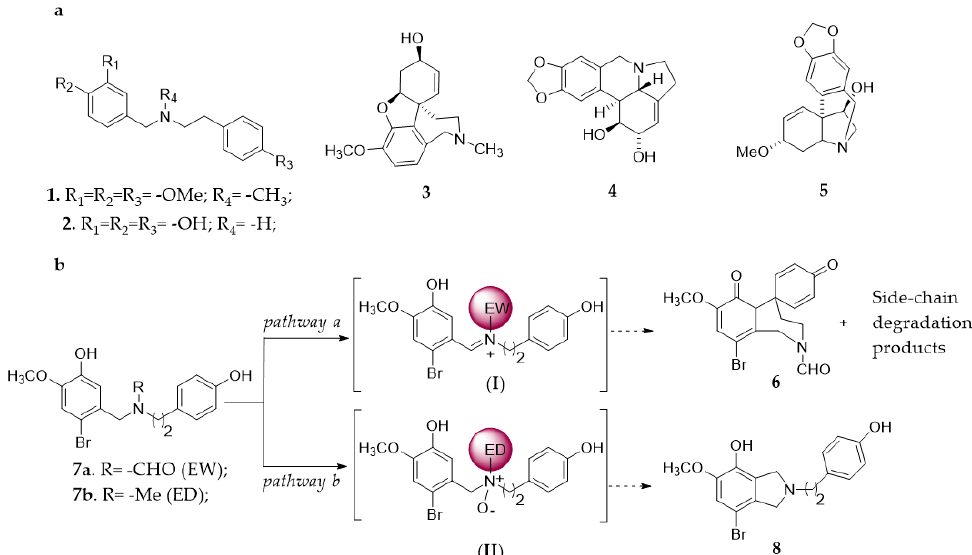
Figure 1. Panel ( a ): chemical structure of belladine 1 , norbelladine 2 , galantamine 3 , lycorine 4 , and haemanthamine 5 . Panel ( b ): side-reactions observed during the oxidation of N -substituted 2-bromo- O -methylnorbelladines 7a – b with laccase from Trametes versicolor . Pathway a : formation of the iminium ion intermediate ( I ) in the presence of electron-withdrawing (EW) substituent and successive transformation to spyrocyclohexadienone 6 . Pathway b : formation of the N -oxide intermediate ( II ) in the presence of electron-donating (ED) substituent followed by phenolic intramolecular cycloaddition to isoindoline 8 .